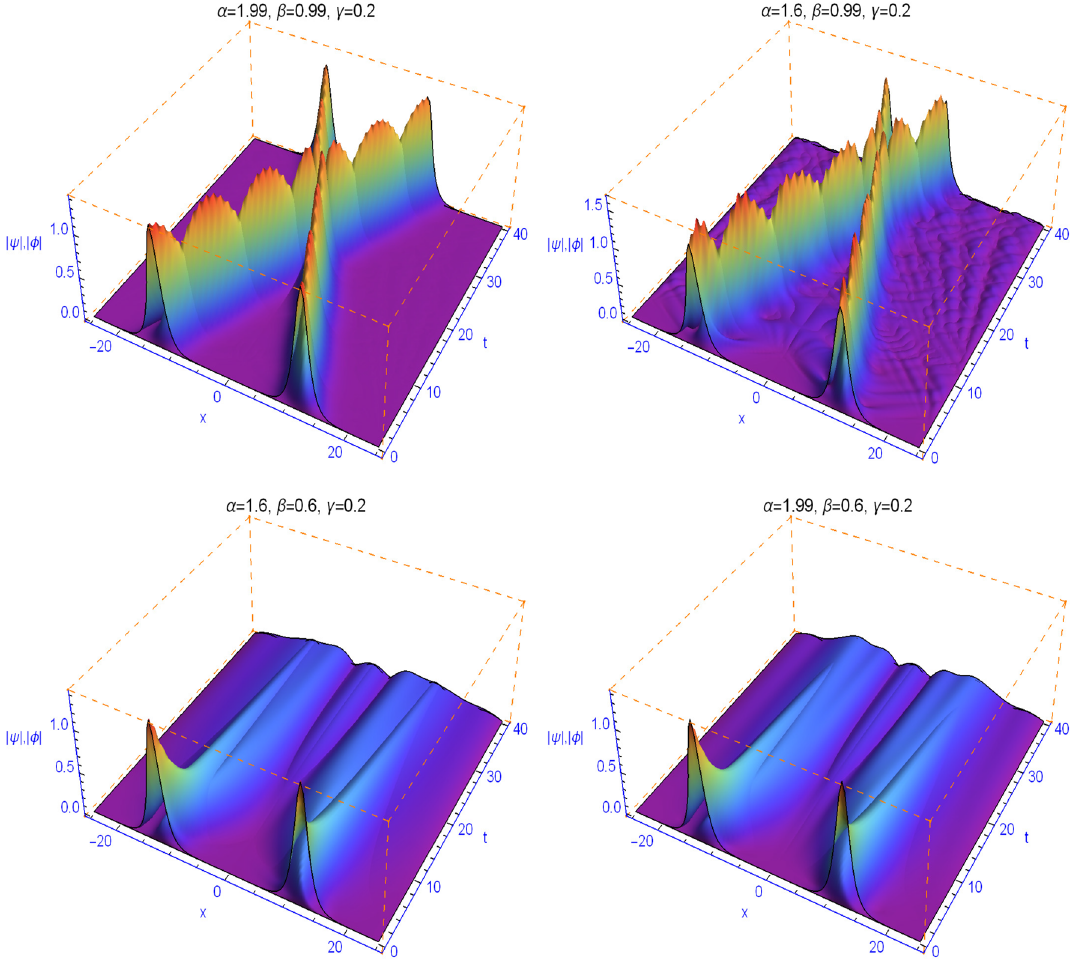
Figure 8. Numerical simulations for Example 2 with γ = 0.2 and different values of the space and time fractional